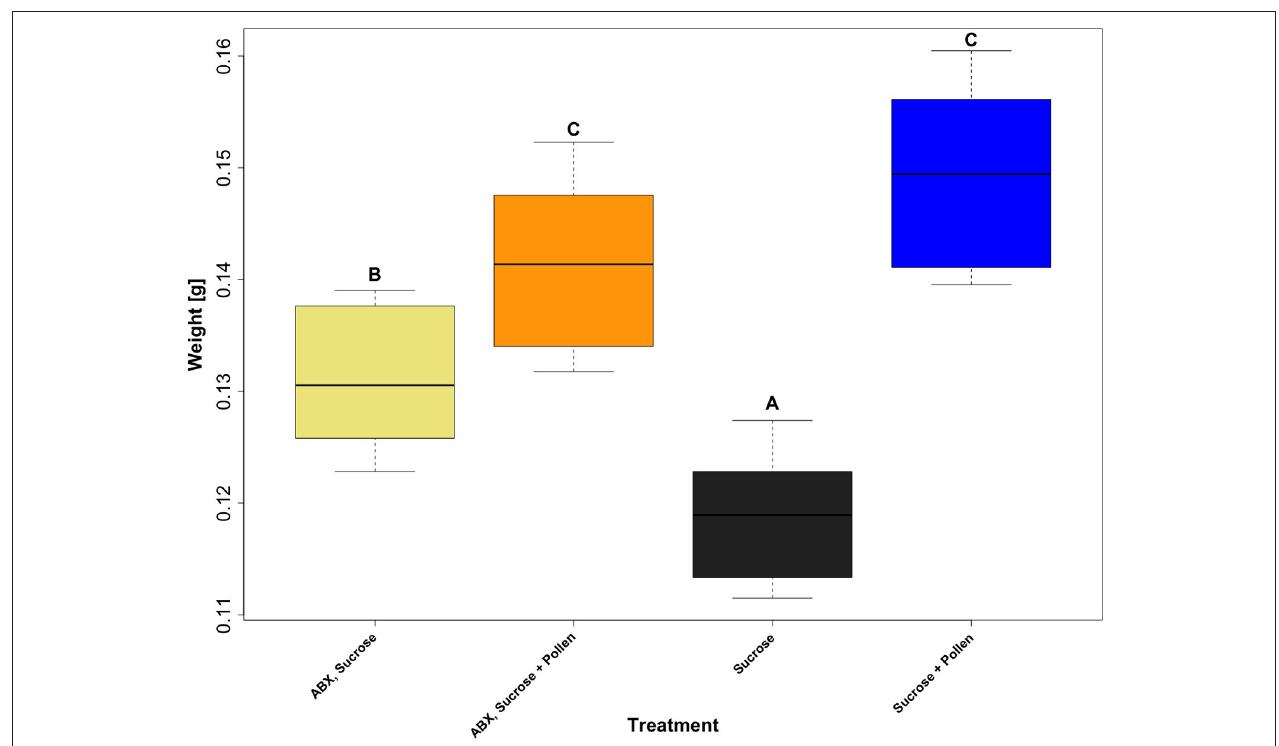
FIGURE 2 | Boxplots of the predicted body weight values of adult workers, Apis mellifera , from four treatment groups: ABX + Sucrose, ABX + Sucrose + Pollen, Sucrose, and Sucrose + Pollen, extracted from a generalized linear mixed effect model (glmer) which was calculated using the weight of the workers, dependent on diet (treatment), and “cage” and “day” as random variables ( N = 4 treatments, N = 60 workers per treatment, and total N = 240 total workers). Post-hoc testing from the glmer, comparing group means (Tukey), with Holm correction was used to determine statistical significance. Compact letter display shows indicated groups who vary statistically ( P < 0.05).